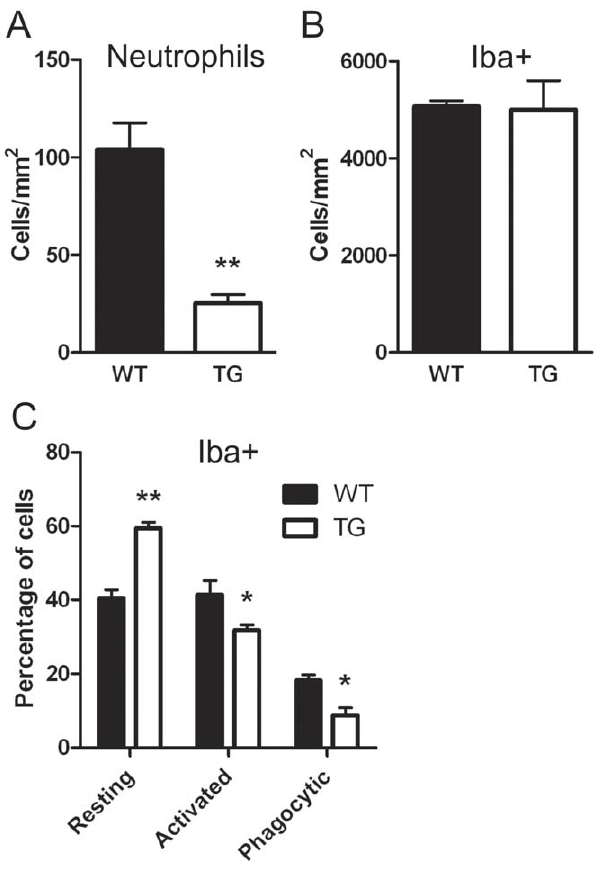
Figure 4. DSCR1-TG mice exhibit reduced brain inflammation following stroke. The number of neutrophils was significantly reduced in DSCR1-TG versus WT brains following stroke (A). While there was no difference in the density of Iba + cells between DSCR1-TG and WT mice (B), more of these cells were in a resting state and fewer in activated or phagocytic states in DSCR1-TG (C). The data are presented as mean 6 SEM (n=3 per group). (*P , 0.05, **P , 0.01).